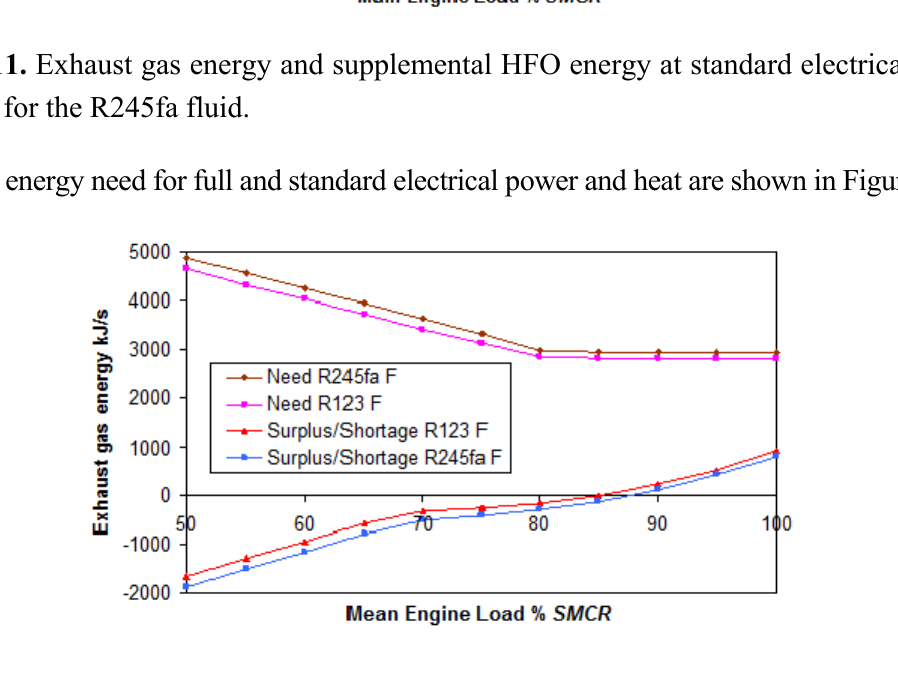
Figure 12. Exhaust gas energy need and surplus/shortage of energy at full electrical power and heat.